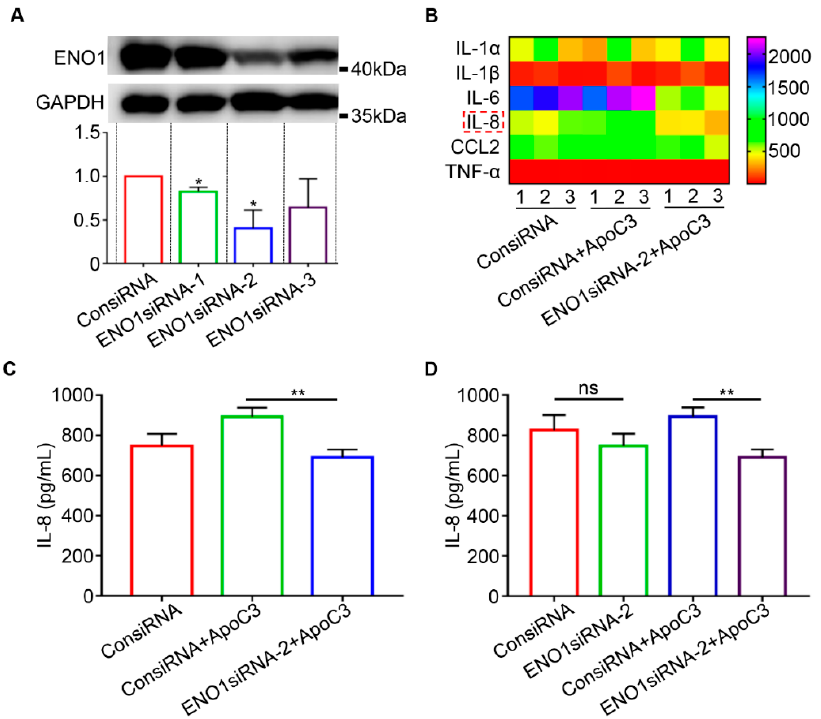
Figure 4. ENO1 induced proinflammatory cytokines in CAL27 supernatant and was dependent on ApoC3. ( A ) Western blot analysis for verifying ENO1 expression after control siRNA (ConsiRNA) and ENO1siRNA-1/2/3 transfection in CAL27 cells. ( B ) Heatmap of the production levels of the inflammatory cytokines in the cultured CAL27 cell supernatant, tested through a QAH-INF-1 cytokine antibody array. ( C ) Quantification of IL-8 production levels in the cultured CAL27 cell supernatant determined by the inflammatory cytokine assay. ( D ) Quantification of IL-8 production levels in the cultured CAL27 cell supernatant determined by ELISA. ** p < 0.01; ns is not significant. Each experiment was repeated at least three times .